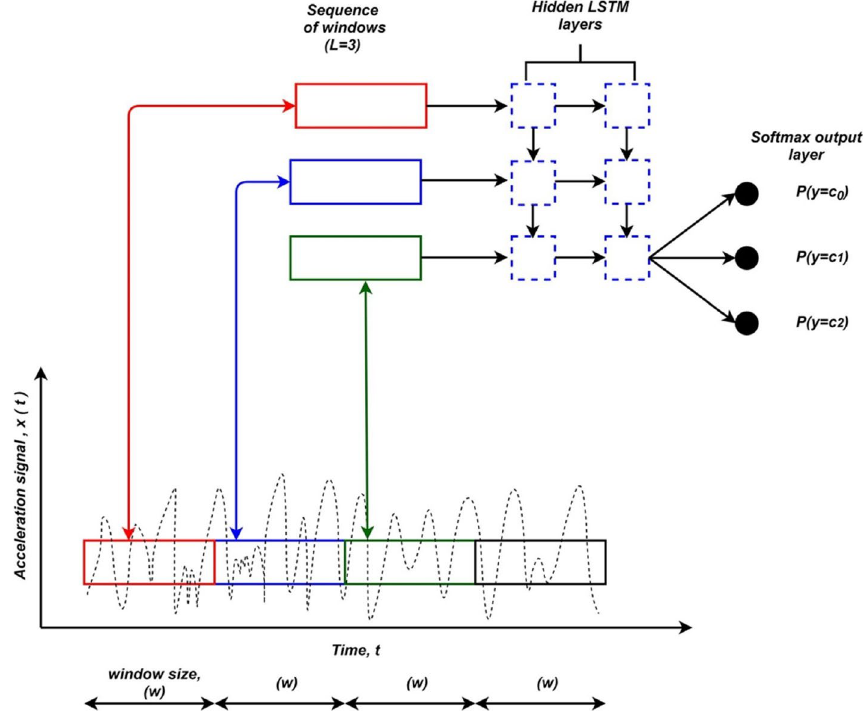
Fig. 5 The sequence of windowed samples extracted for the training of LSTM (Sony et al